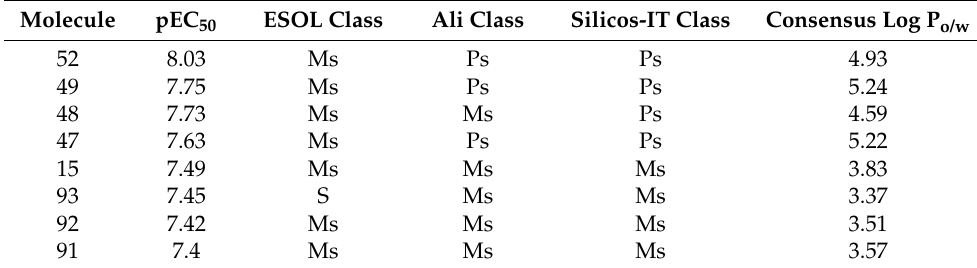
Figure 4. BOILED-EGG plot showing the probability of human intestinal absorption (HIA) and blood–brain barrier (BBB) permeation of the studied molecules. Table 3. Properties calculated from ADME, solubility (S = Soluble, Ms = Moderately soluble, Ps = Poorly soluble), and log P o/w